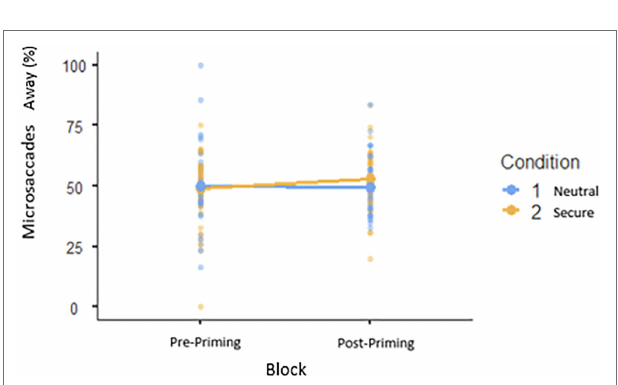
FIGURE 4 | Attention pre- and post-priming: No difference captured by analysis of microsaccades away from the